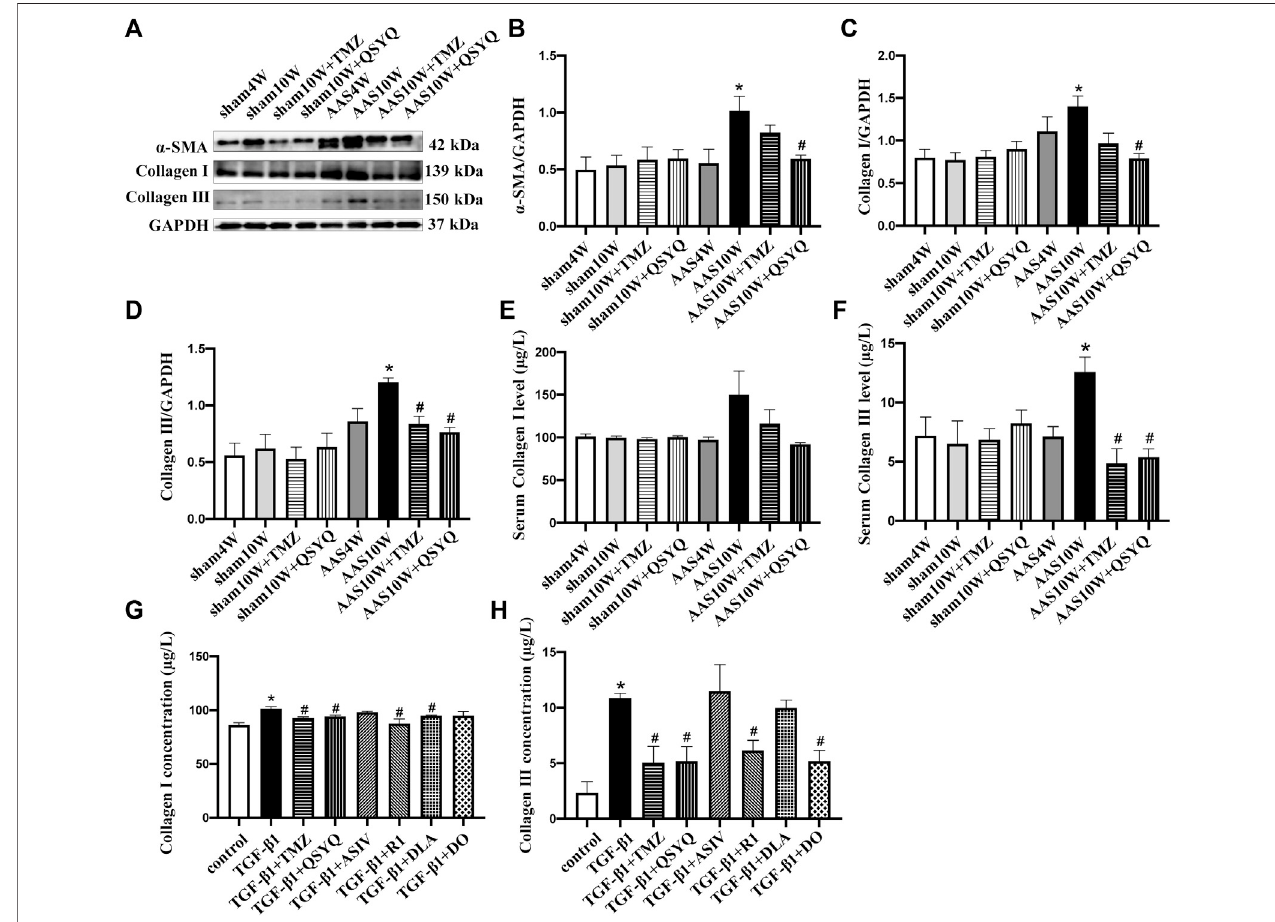
FIGURE 7 | QSYQ ameliorated collagen production both in vivo and in vitro . (A) Expression of α -SMA, collagen I and collagen III in rat myocardium examined by Westernblot. (B – D) Quanti fi cationoftheWesternblotresultsfor α -SMA,collagenIandcollagenIII.Dataarepresentedasthemean±SEM, n =4. (E,F) SerumcollagenI and collagen III levels detected by ELISA. (G,H) Collagen I and collagen III levels in TGF- β 1-stimulated RDF cell supernatants examined by ELISA. Data are presented as the mean ± SEM, n = 6. * p < 0.05 vs. sham or control; # p < 0.05 vs. AAS or TGF- β